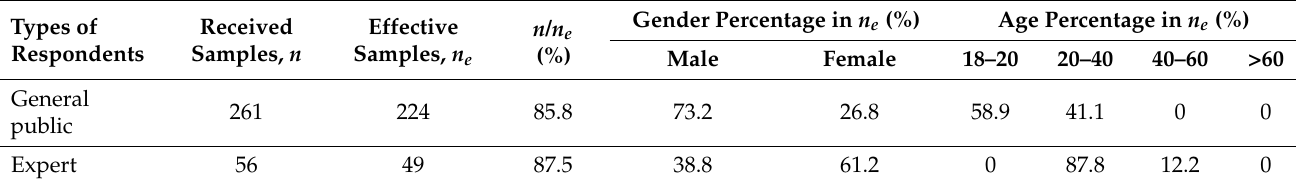
Table 1. Background data of survey